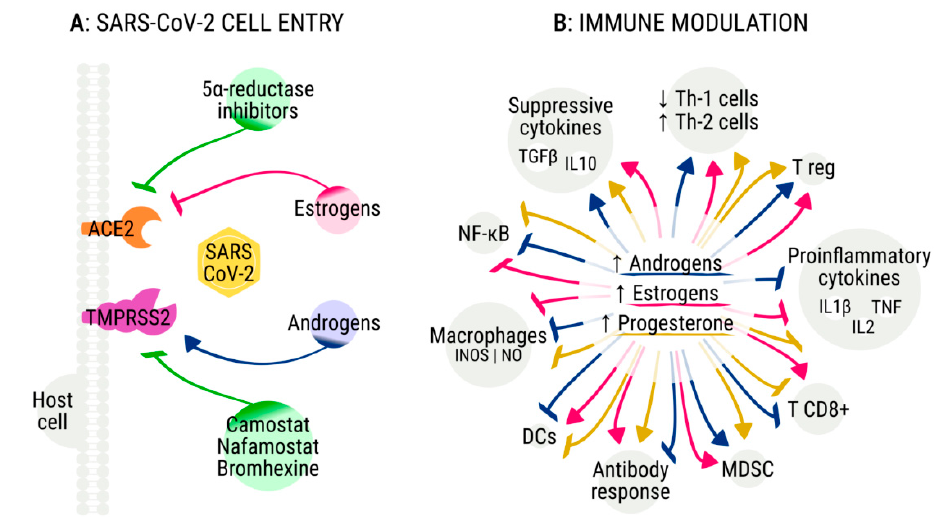
Figure 1. The role of sex hormones and hormone therapies in modulating severe acute respiratory syndrome coronavirus 2 (SARS-CoV-2) entry in host cells and immune response. ( A ) A proposed model suggests that androgens can upregulate the activity of transmembrane serine protease 2 (TMPRSS2), which is necessary for the SARS-CoV-2 spike protein priming; several TMPRSS2 inhibitors are under investigation in clinical trials. In vitro data also suggest that estrogens might downregulate the angiotensin-converting enzyme 2 (ACE2) expression, which is used by SARS-CoV-2 for host cell entry. ( B ) Androgens (blue arrows), estrogens (pink arrows), and progesterone (yellow arrows) can activate and inhibit several components of the immune response against SARS-CoV-2, a ff ecting the clinical course and disease severity of patients with COVID-19. TGF β —transforming growth